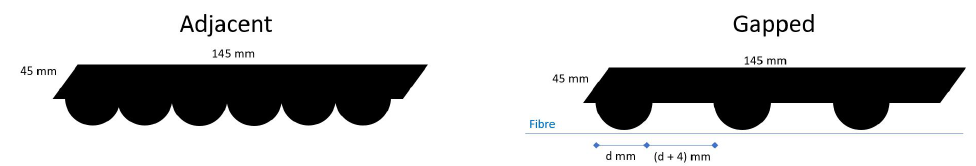
Figure 2. Impactor construction methods, showing the size and spacing of the adjacent and gapped styles of